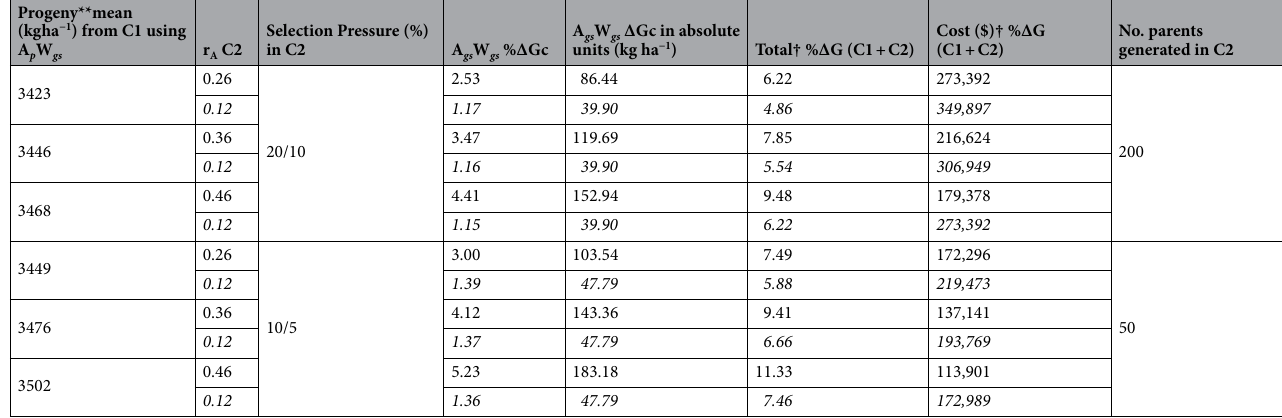
Table 7. Cycle 2 (C2) is based on genomic selection (GS) applied to among and within HS family progeny generated from polycrossing the elite parents identified in cycle 1. Combinations of among and within ( among/ within ) HS family selection at pressures of among/within, 20%/10% and 10%5%, and different genomic prediction accuracies (r A ) were applied. From within each of 100 HS families from cycle 1 generated at 20%/10% and 10%/5% selection pressure, random samples of 100 seedlings per family were used in cycle 2, a total of 10,000 individuals subjected to GS. The costs per percent genetic gain (relative to the C1 HS family predicted progeny means), are based on $41 for generating a single GEBV (genomic estimated breeding value). The length of C2 is 1 year. Percentage genetic gain per cycle of selection (%ΔGc), cost per percentage of predicted genetic gain ($ per % gain). r A, is the Pearson correlation coefficient between Phenotypic Estimated Breeding Values and Genomic Estimated Breeding Values, based on the predicted equation developed in C1. Among and within half-sib family genomic selection (A gs W gs ). In C2 a r A of 0.12, predicted in cycle 2 of stochastic simulation using Sim200 HS families, was used in deterministic simulation to model a possible scenario of r A decay, displayed in italics in the table. **, mean of 1000 HS families plus predicted ΔG in C1; †, sum of gain (%ΔGc) and costs ($) from C1and